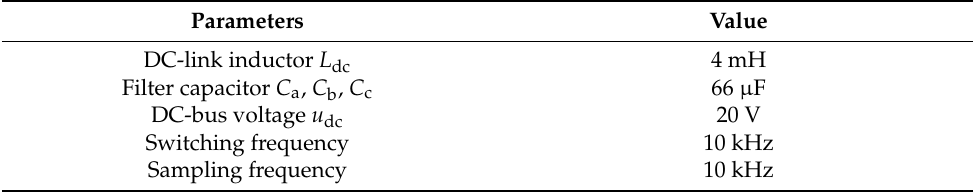
Table 3. Simulation parameters.